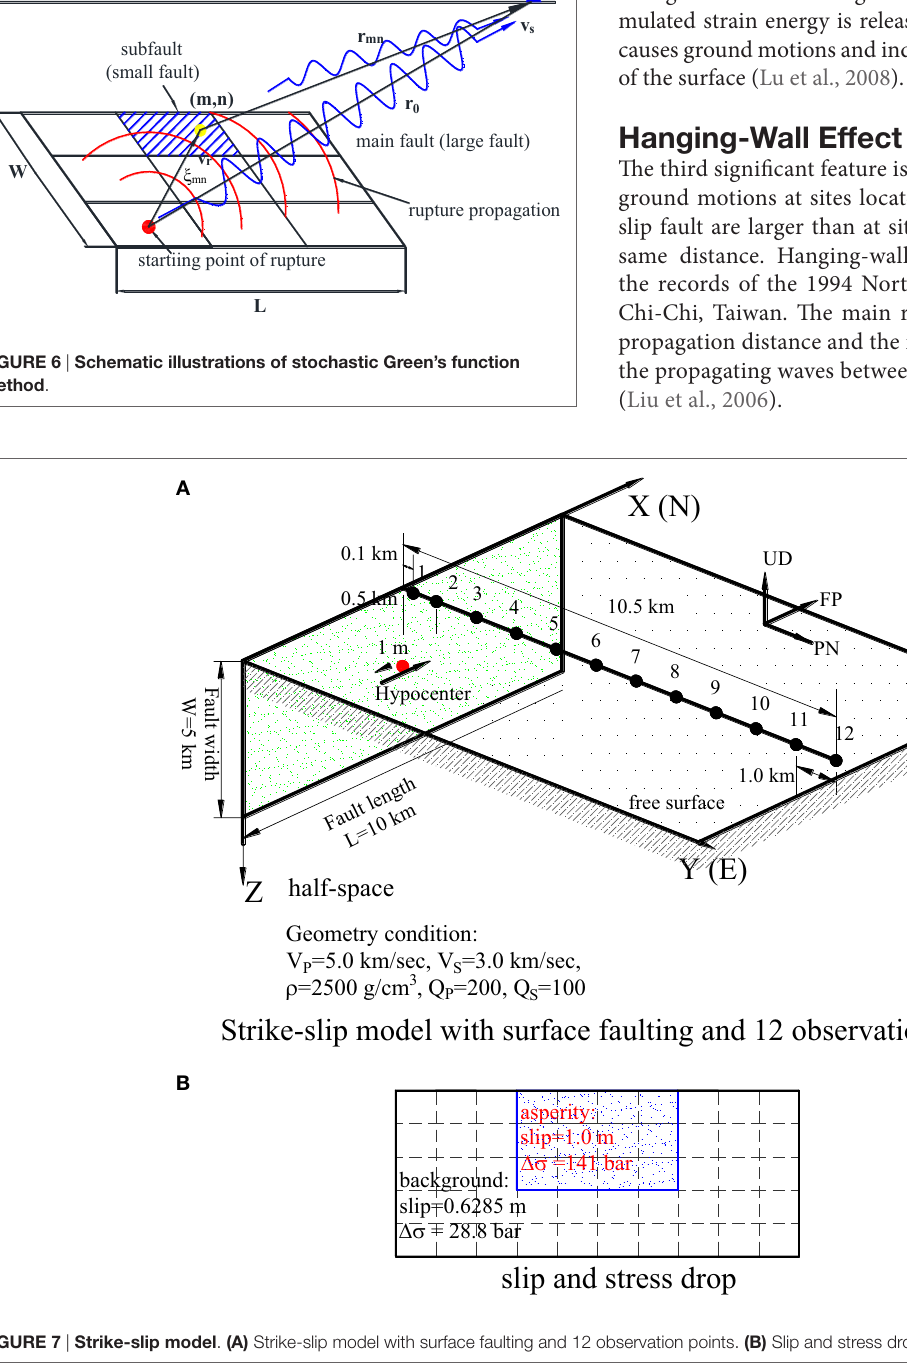
FigUre 7 | strike-slip model . (a) Strike-slip model with surface faulting and 12 observation points. (B) Slip and stress